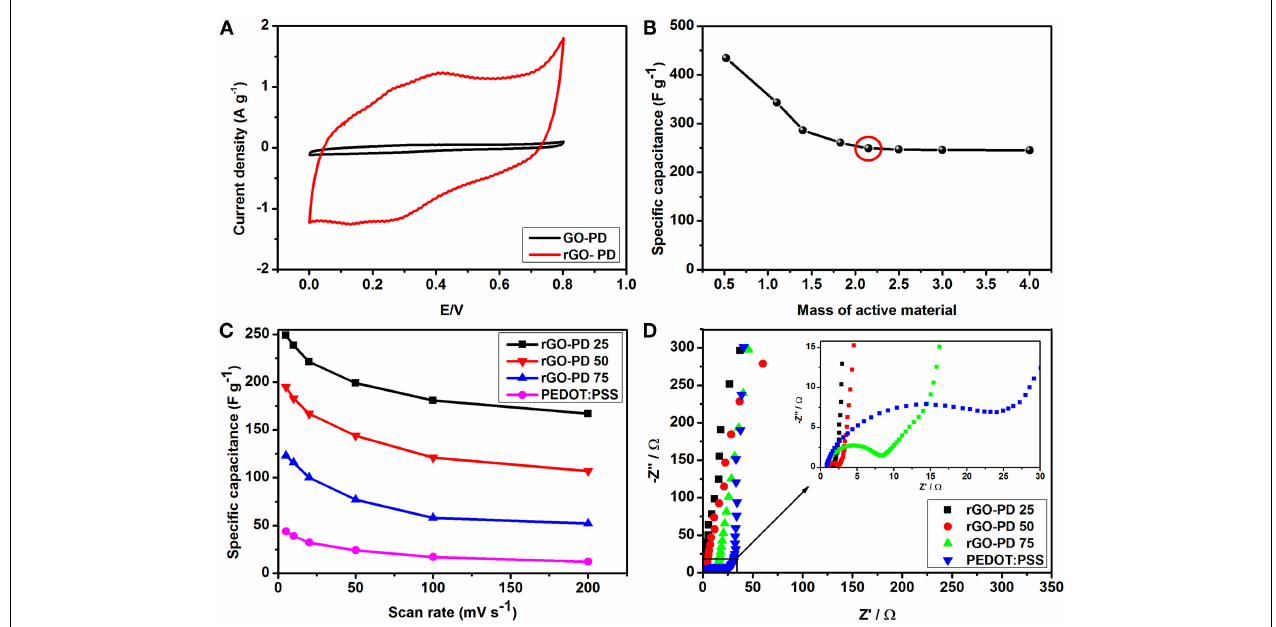
FIGURE 6 | Electrochemical performance of rGO–PP 25 composite in a three-electrode system: (A) cyclic voltammograms of the composite electrodes before and after chemical reduction, (B) specific capacitance of rGO–PP 25 composite electrodes with different mass loading at 5mVs − 1 , marked with the minimum active material mass for further electrochemical characterization, (C) variation of specific capacitance of different composites including PEDOT:PSS with scan rates, and (D) Nyquist plots of different composite electrodes.The inset shows the corresponding magnified high frequency region